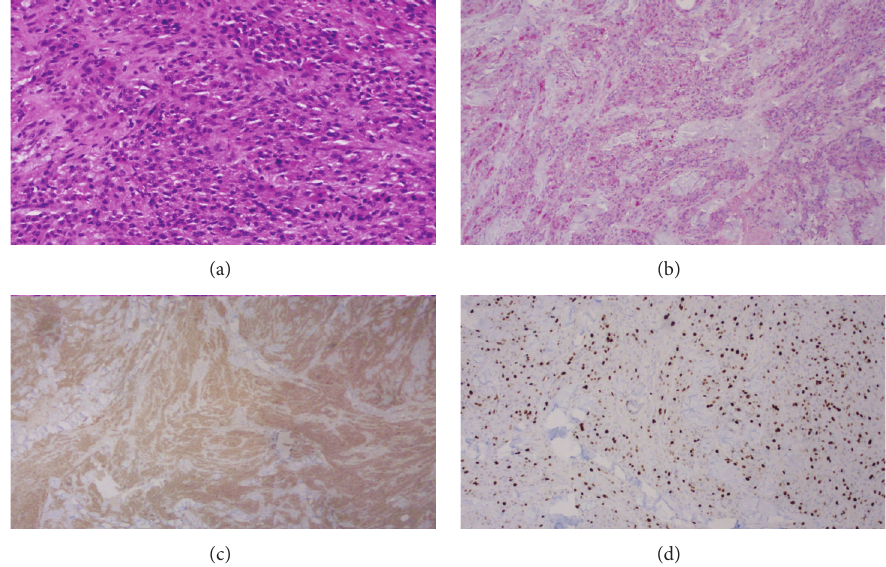
Figure 1: (a) High-power magnification of biopsy specimen (5 mitoses per 10 high power field), (b) S-100 immunohistochemistry stain of biopsy specimen, (c) CD68 immunohistochemistry stain of biopsy specimen, and (d) KI-67 proliferation marker of biopsy specimen.